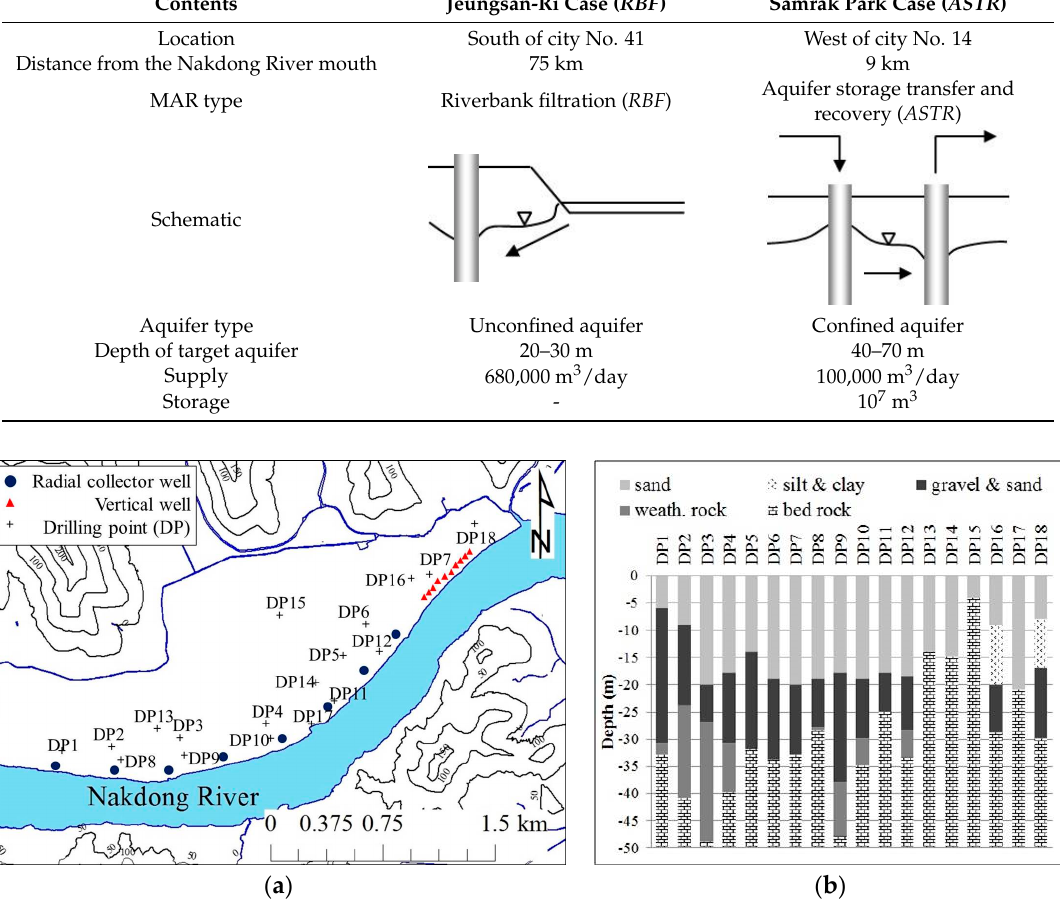
Table 1. Characterization of two MAR cases. Riverbank filtration ( RBF ); aquifer storage transfer and recovery ( ASTR ).